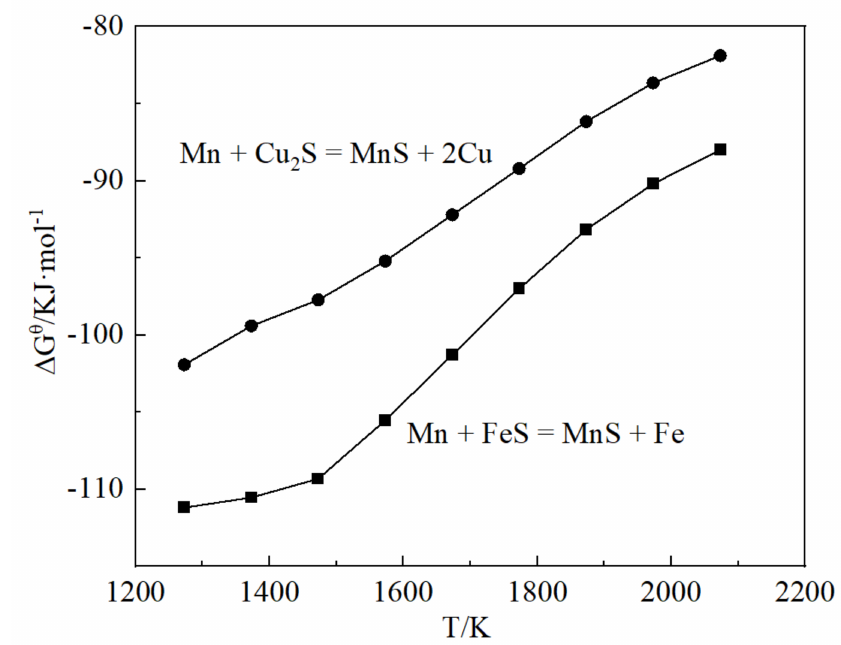
Figure 5. The Gibbs free energy of Mn desulfurization